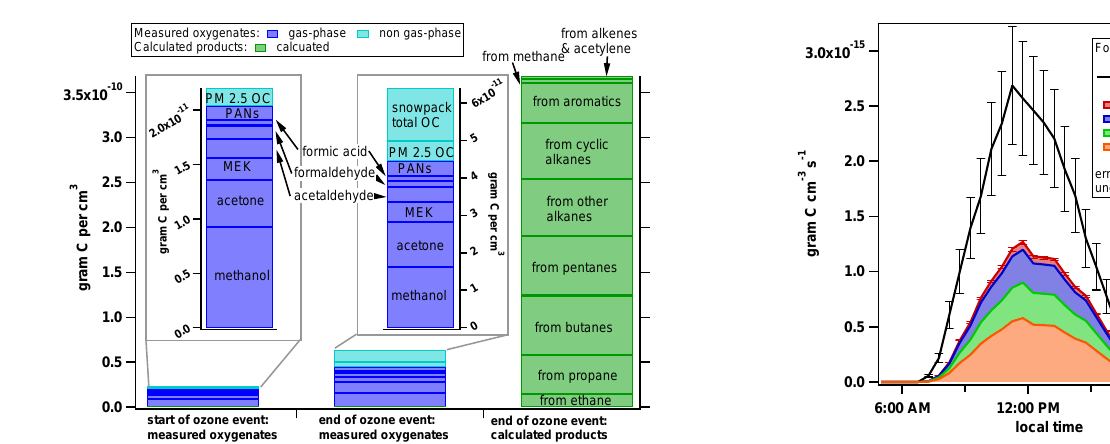
Figure 11. Comparison of total product formation rates (black) and measured carbonyl formation rates. There is a substantial gap that indicates the formation of other oxidation